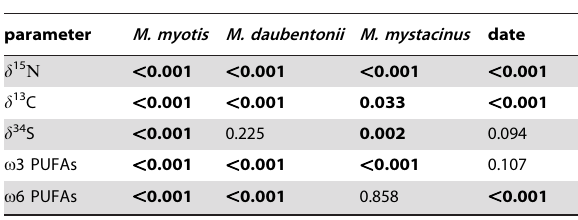
Table 3. Results from the general linear models (GLMs) applied to each stable isotope ( d 15 N, d 13 C, d 34 S) and fatty acid parameter ( v 3, v 6 PUFAs) with species ( Myotis myotis , M. daubentonii , M. mystacinus ) and date as explaining variables.